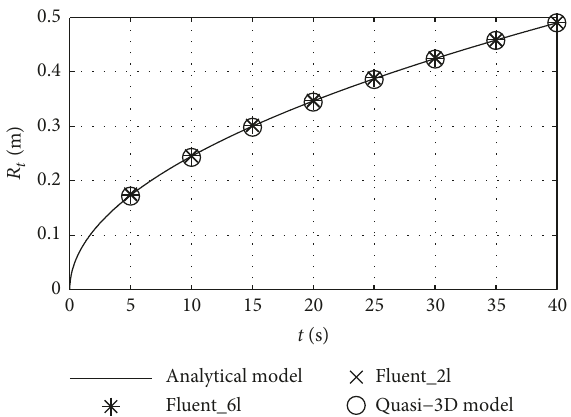
Figure 8: Comparison of diffusion radius variation with time among three models in Case